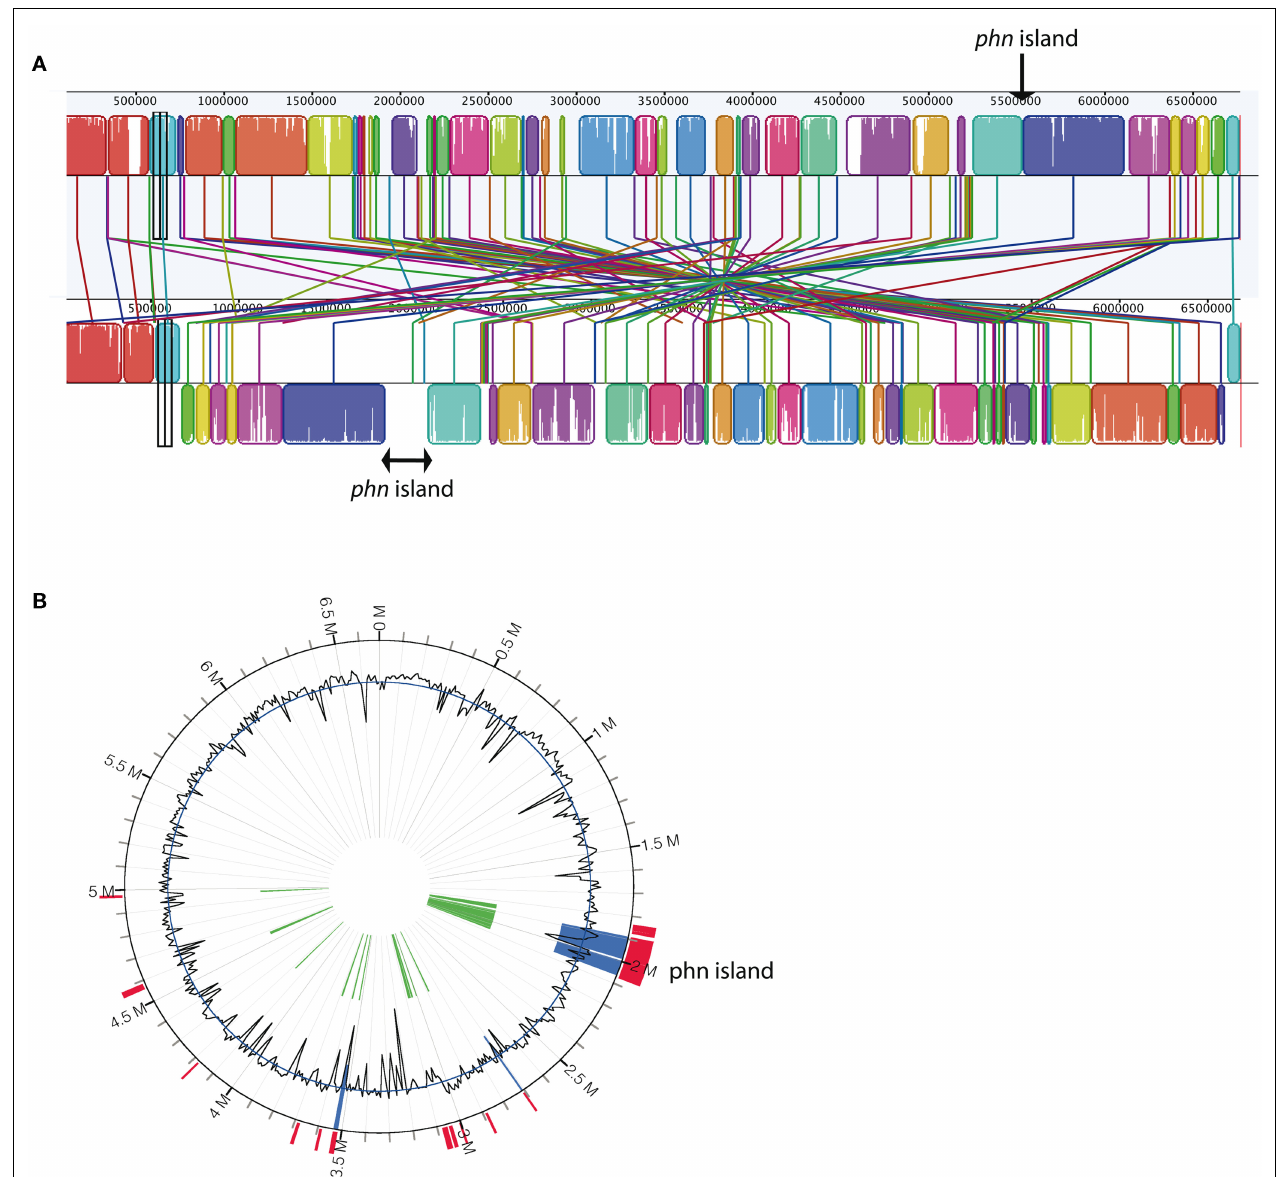
bordering the island are (5 (cid:3) –3 (cid:3) ) DelCs14_1618 and DelCs14_1848; corresponding loci in strain SPH1 are Daci_4996 and Daci_4997, respectively. (B) IslandViewer analyses of the Delftia sp. Cs1-4 chromosome, with colored regions indicating genomic islands.